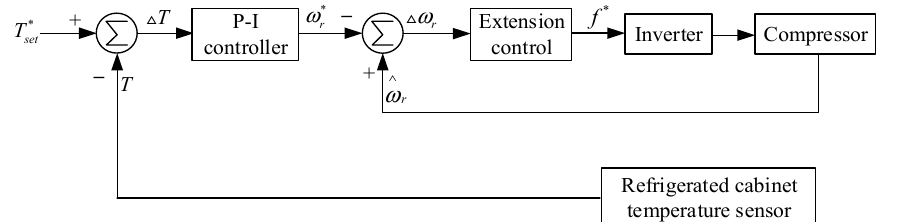
Figure 7. Closed loop control architecture of compressor drive system.